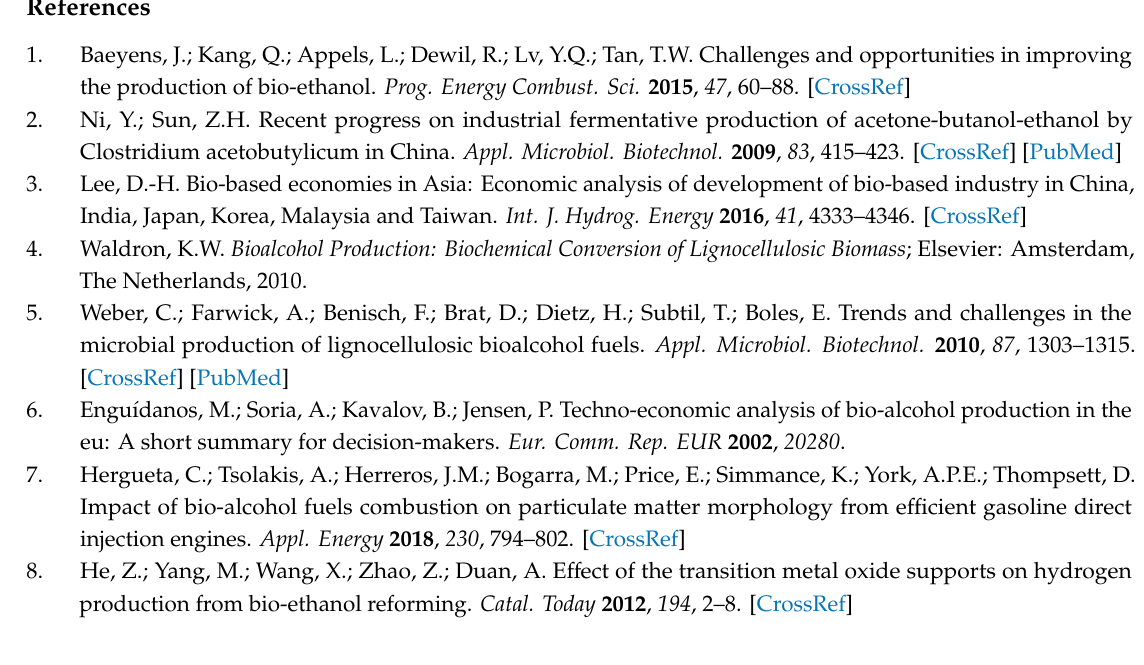
Figure S1: Schematic representation of hybrid catalyst synthesis (SDA = structure directing agent, in our case tetrapropyl ammonium hydroxide, TEOS = tetraethyl orthosilicate), Figure S2. NH3-TPD spectra for c-HZSM-5 (black), n-HZSM-5 (red), PM-50 / 50 (grey), Hybrid-50 / 50 (green) and γ -Al 2 O 3 (blue). Starting temperature = 150 ◦ C, heating ramp = 10 K min − 1 , the intensities are weight-normalized, Figure S3. NH3-TPD profiles with deconvolution of c-HZSM-5 (a), n-HZSM-5 (b), PM-50 / 50 (c), Hybrid-50 / 50 (d) and γ -Al 2 O 3 (e). The weak acid site contribution to the spectrum is depicted as (—), the medium acid sites as (-.-) and the strong acid sites as ( ... ), Figure S4. SEM-images of c-HZSM-5 (a) n-HZSM-5, with crystal size bars (b) and Hybrid-50 / 50 (c,d), Figure S5. Selectivity of products versus conversion, c-HZSM-5 ( (cid:4) , black), n-HZSM-5 ( (cid:4) , red), PM-50 / 50 ( (cid:78) , purple), Hybrid-50 / 50 ( Error bars indicate the 95% confidence